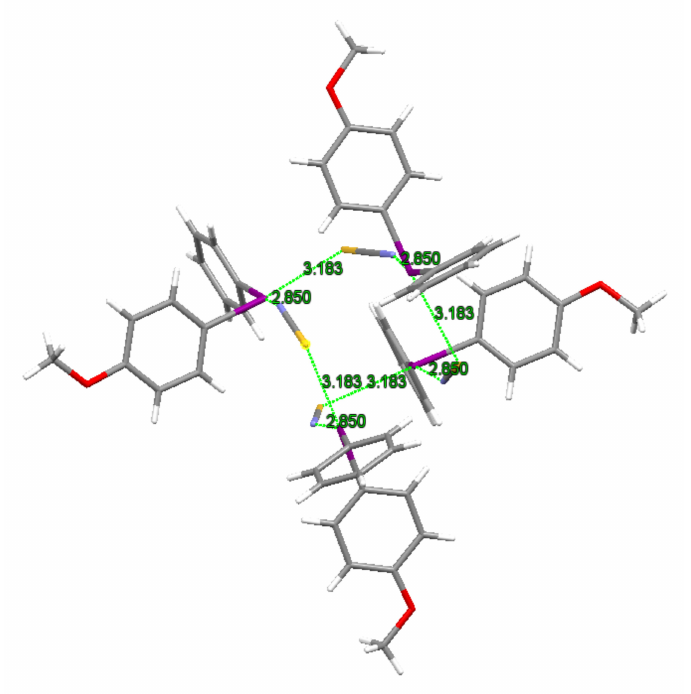
Figure 3. 16-membered cyclic heterooctamer formed via halogen bonds between the SCN − and iodonium cation in the crystal of 4-methoxyphenyl(phenyl)iodonium thiocyanate, [PhI(4- C 6 H 4